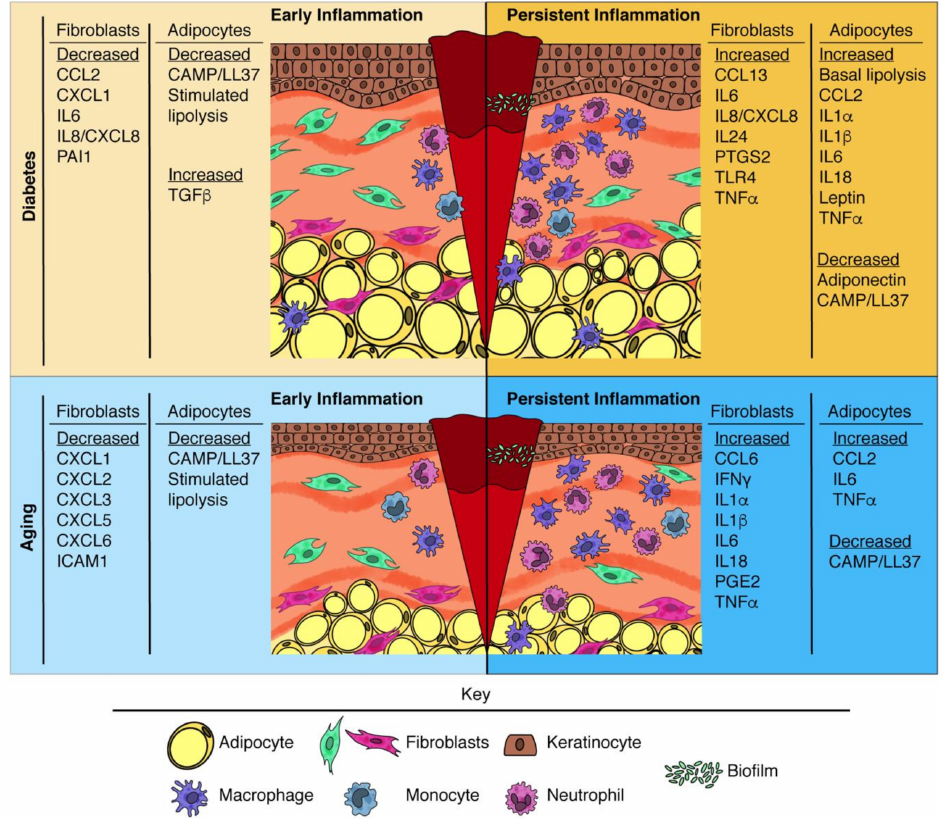
Figure 2. Changes in mesenchymal cell-derived immune regulators during impaired wound healing. Diagrams show representative changes to diabetic and aged skin. Diabetic skin undergoes expansion of the dermal white adipose tissue (DWAT) and a reduction in fibroblasts. Aged skin is thinner, with flatter keratinocytes, diminished DWAT, and fewer fibroblasts. Initially after injury, there is an impaired initial activation and recruitment of leukocytes to the site of injury. At later time points after injury, there is a persistence of inflammatory neutrophils and macrophages. Panels designate changes in pro- and anti-inflammatory factors from fibroblasts and adipocytes that can contribute to the altered leukocyte responses that occur with diabetes and